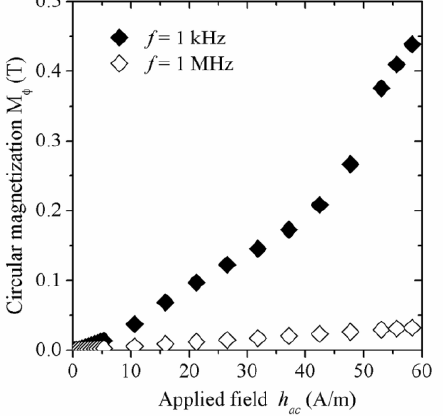
Fe ) B Si amorphous 0.94 0.6 72.5 15 12.5